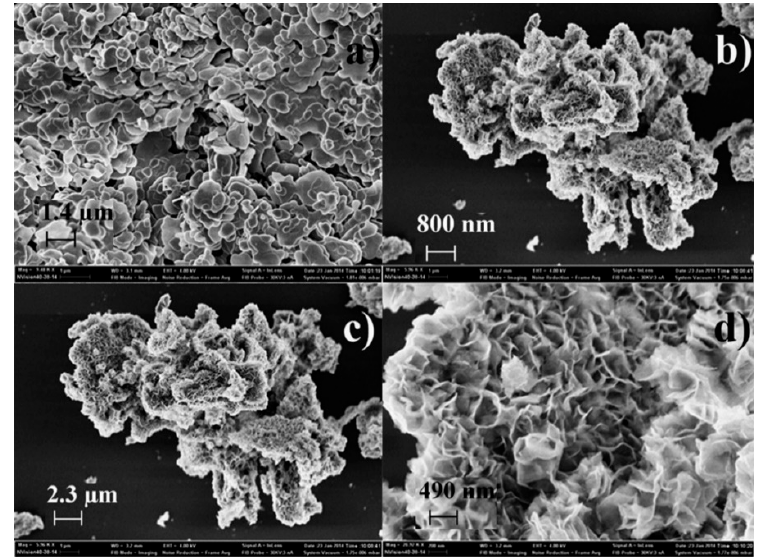
Figure 4. SEM images of ( a ) BiOCl platelet clusters at 9.48 e 3 magnification. ( b ) Single BiOCl cluster at 16.6 e 3 magnification. ( c ) BiOI platelet clusters at 5.96 e 3 magnification. ( d ) Single BiOI cluster at 28.9 e 3 magnification. Reused with permission from reference [12]. Copyright Elsevier 2015.